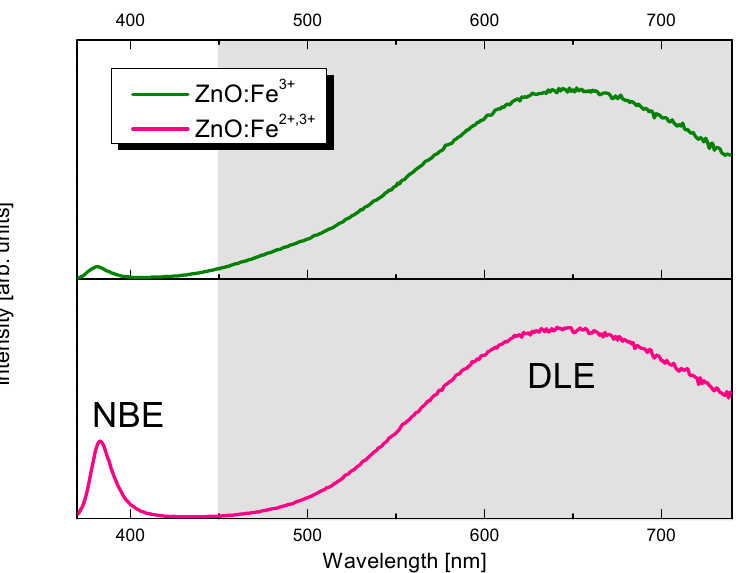
Figure 6. Photoluminescence spectra ( λ exc = 300 nm) of ZnO:Fe 3+ (upper) and ZnO:Fe 3+,2+ (lower) samples.